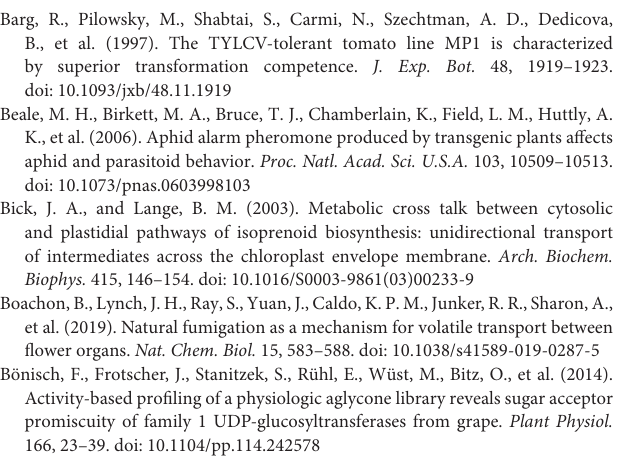
Supplementary Figure 1 | Metabolic profiling of transgenic tomato lines overexpressing AmNES/LIS-1 and AmNES/LIS-2 under control of the PG promoter. Emission of the sesquiterpene nerolidol (A) and the monoterpene linalool (B) from ripe tomato fruits ( AmNES/LIS-1 line B5 and AmNES/LIS-2 line U8) were analyzed by GC-MS. IS, internal standard. Supplementary Figure 2 | Mass spectra of two unknown terpene compounds observed in the internal pools extracted from AmNES/LIS-1 fruits (see Figure 4A ). Extracts were analyzed by GC-MS and mass spectra are shown for: (A) unknown terpene 1; (B) unknown terpene 2. Supplementary Table 1 | Primers for genotyping and qRT-PCR analyses of transgenic tomato